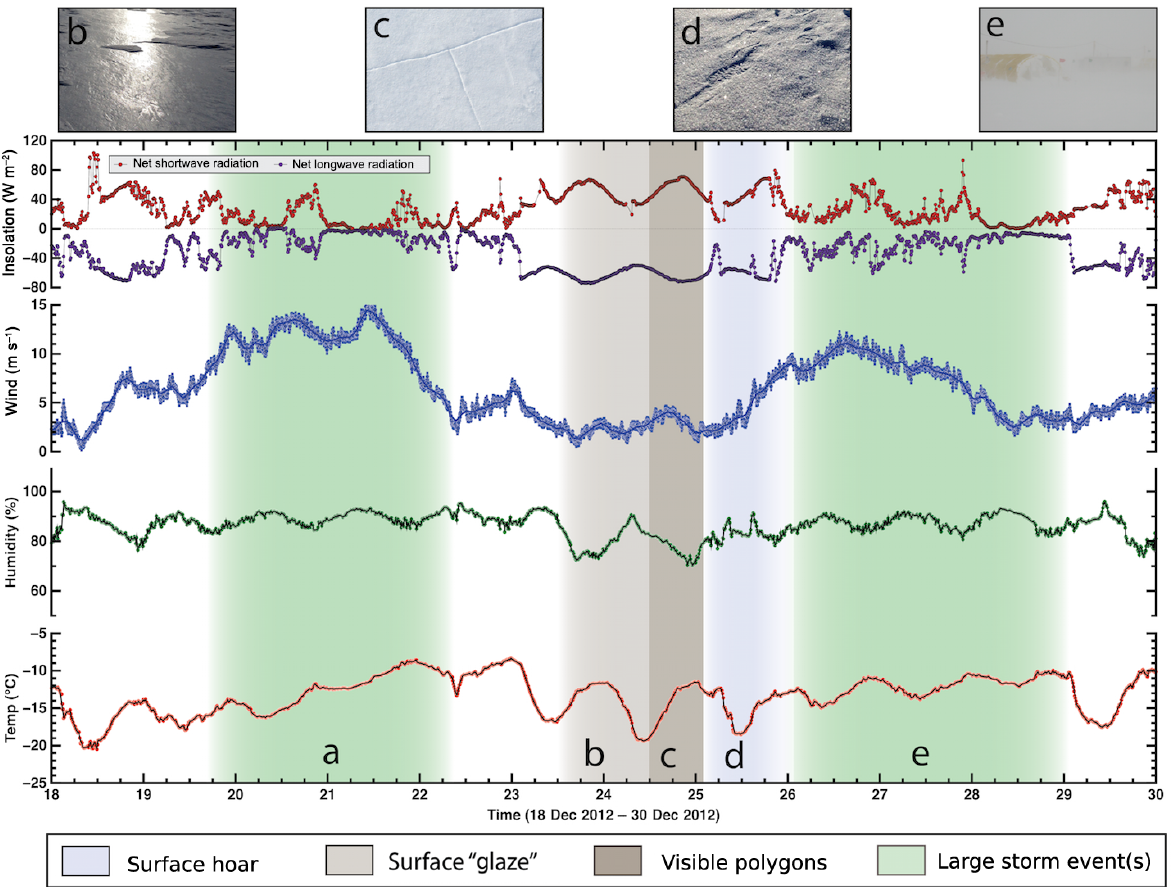
Figure 8. Surface evolution over 12 days in the 2012–2013 season, and AWS data. Shading shows episodes of surface hoar, glazes, and polygonal cracking; storm events are also shown. Letters near the top refer to photographs above of specific features or events. All dates and times are GMT (WAIS local time − 12h). The errors for all AWS instruments are listed in Table S1.